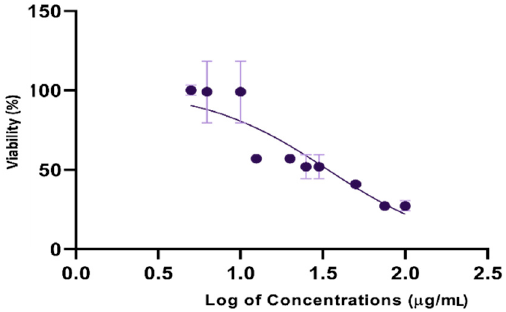
Figure 14. Log viability vs. normalized response-variable slope (three-parameter) of O-AgNPs on the normalized viability of LoVo cancer cell lines.